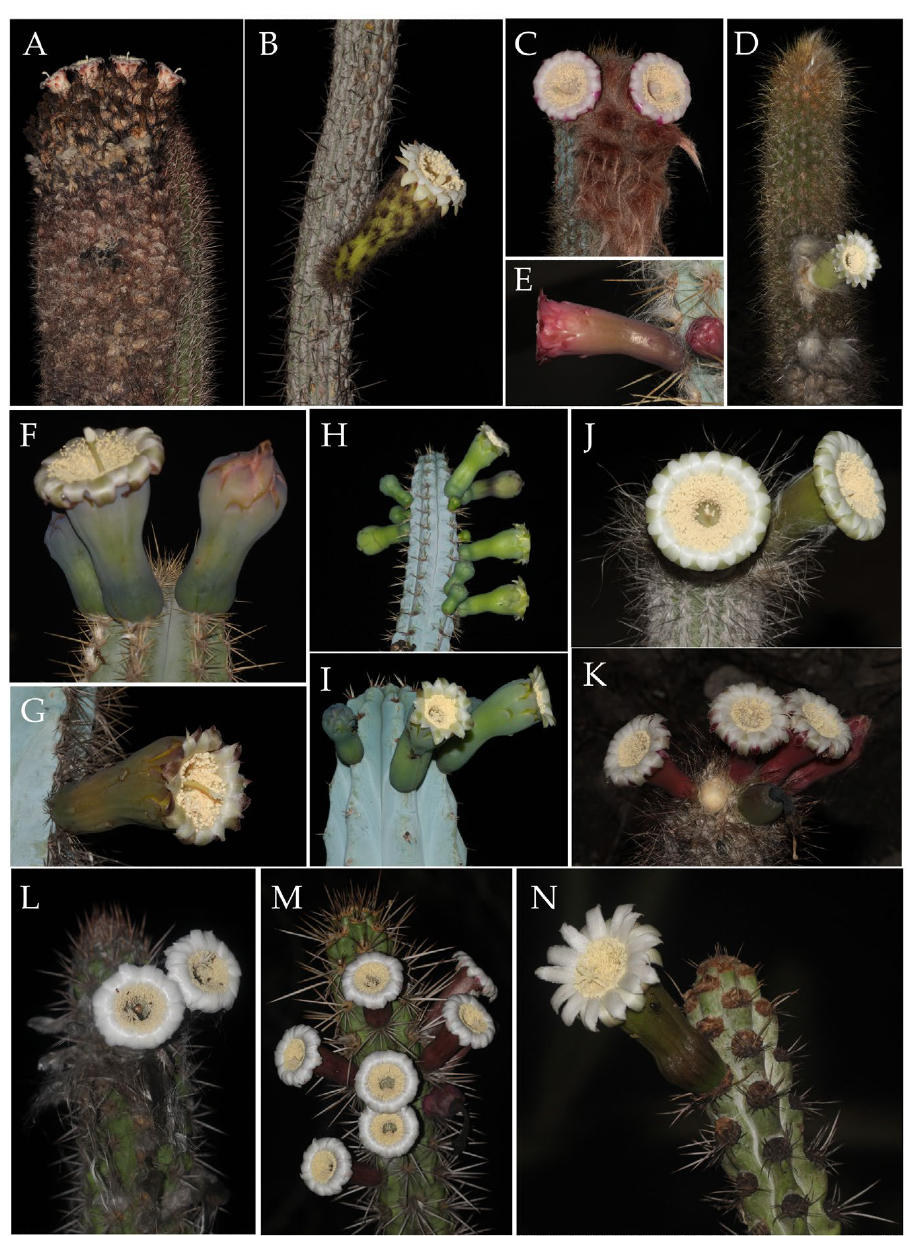
Figure 2. Cereinae species studied displaying floral attributes associated with bat pollination. ( A ) Coleocephalocereus goebelianus , ( B ) Leocereus bahiensis , ( C ) Micranthocereus purpureus , ( D ) Pilosocereus catimbauensis , ( E ) P. glaucochrous , ( F ) P. catingicola , ( G ) P. pachycladus subsp. pachycladus , ( H ) P. pentaedrophorus subsp. pentaedrophorus , ( I ) P. pentaedrophorus subsp. robustus , ( J ) Stephanocereus leucostele , ( K ) S. luetzelburgii , ( L ) Xiquexique gounellei , ( M ) X. ×heptagonus , and ( N ) X. tuberculatus .